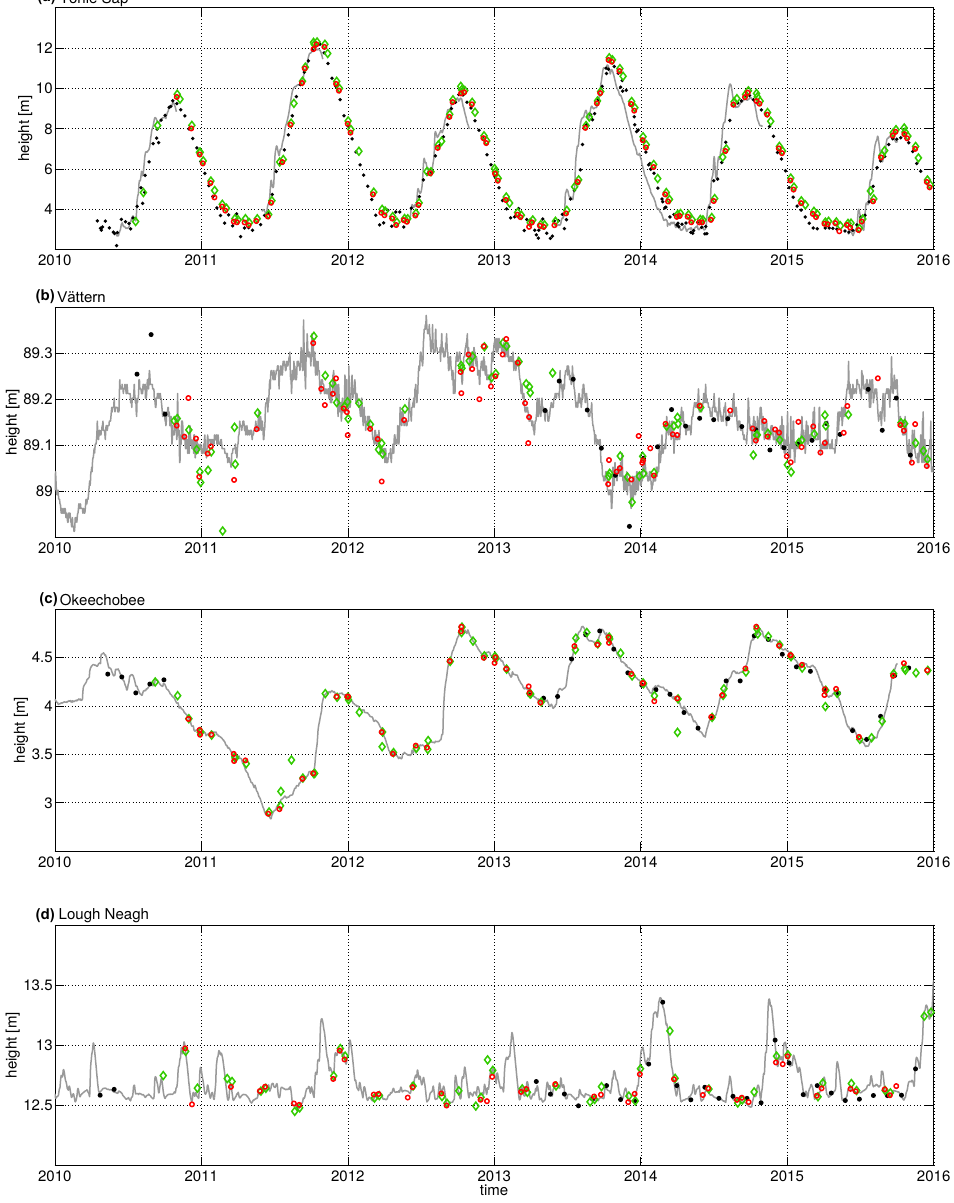
Figure 7. Water level time series solutions for the lakes ( a ) Tonle Sap; ( b ) Vättern; ( c ) Okeechobee; and ( d ) Lough Neagh: DGFI-TUM (red), gauging stations (gray), DAHITI (black) and DTU